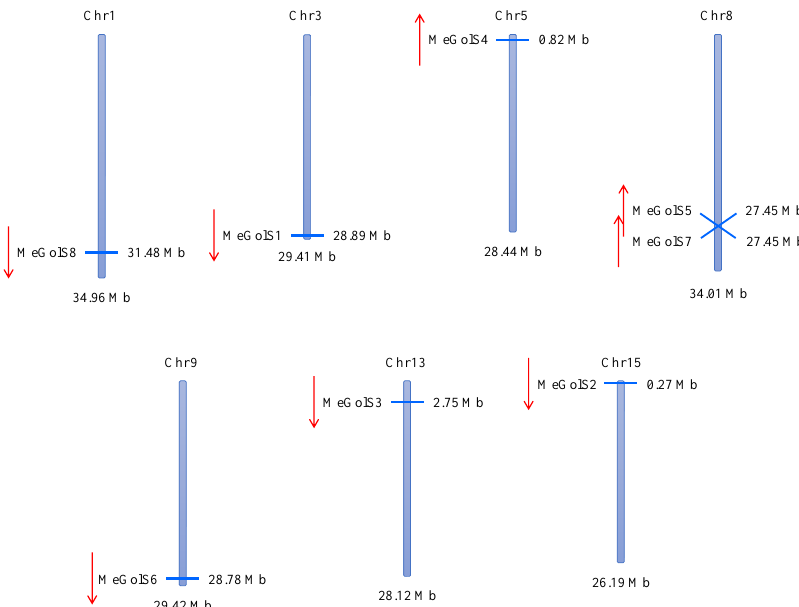
Figure 1. Chromosomal locations of 8 predicted MeGolS genes. The chromosome number is marked upon each chromosome. The red arrows indicate gene orientation on chromosomes. The number below each chromosome indicates chromosome size. The number next to each gene represents the position of the gene on the chromosome.